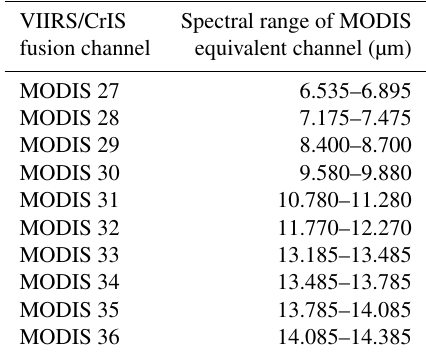
Table 2. The VIIRS/CrIS fusion channels used in the pseudo- labeling model. All channels are expressed as brightness temper-